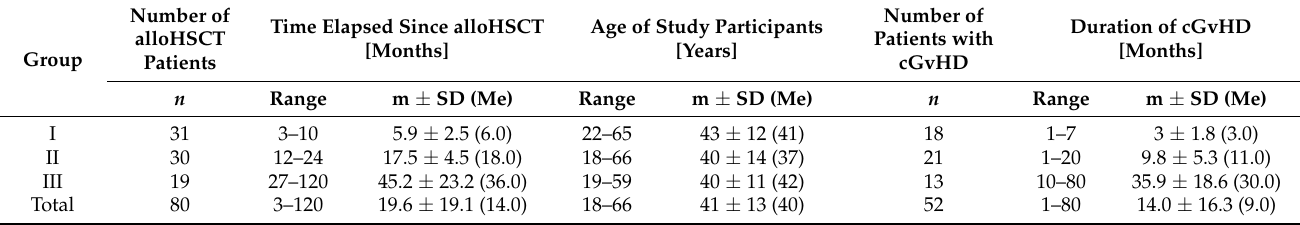
Table 1. Size of patient groups, depending on the time elapsed since alloHSCT, including the occurrence of cGvHD. Number of Time Elapsed Since alloHSCT alloHSCT Group Patients